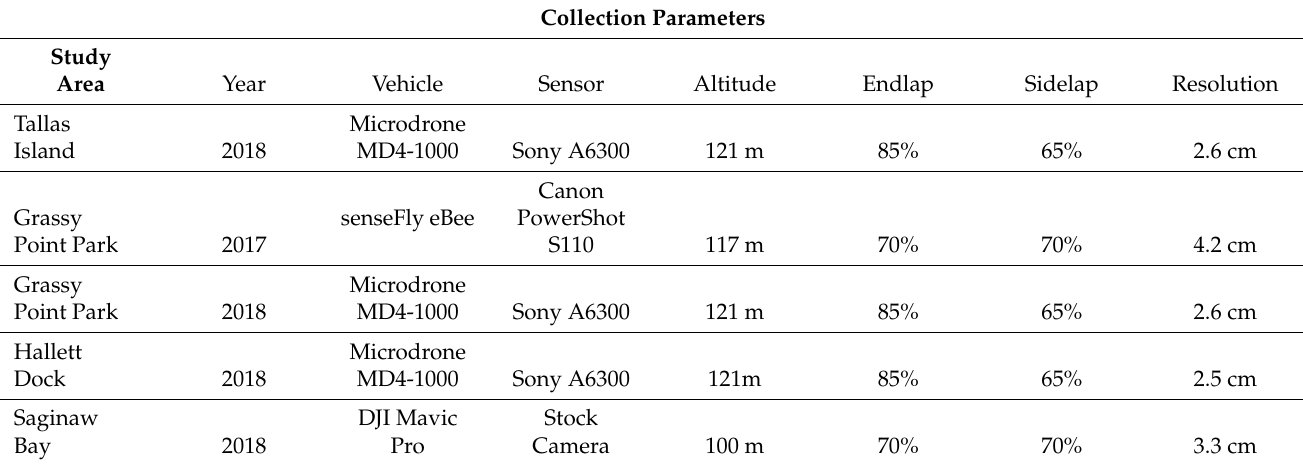
Table 1. Collection parameters for each